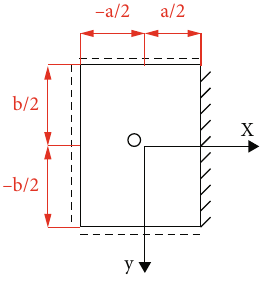
Figure 6: Mechanical model of mutative mining stope I.